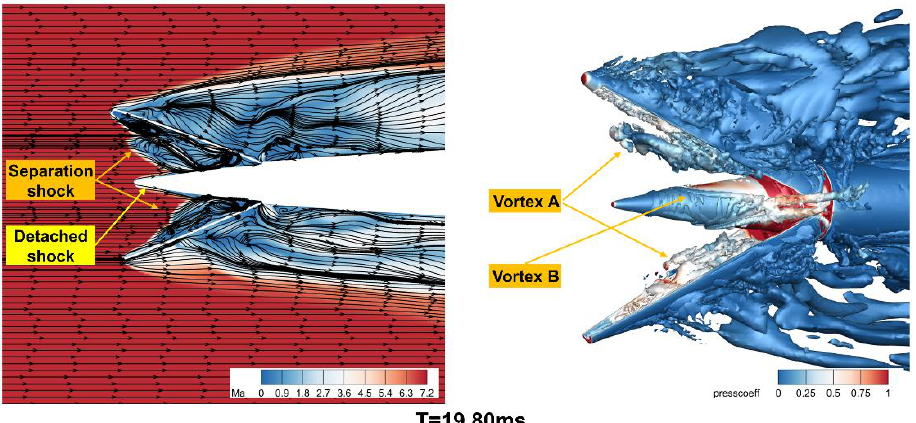
Figure 23. The contour of streamline and Mach number ( left ), and iso-surface of Q-criterion ( right ) at Time = 19.80 ms.